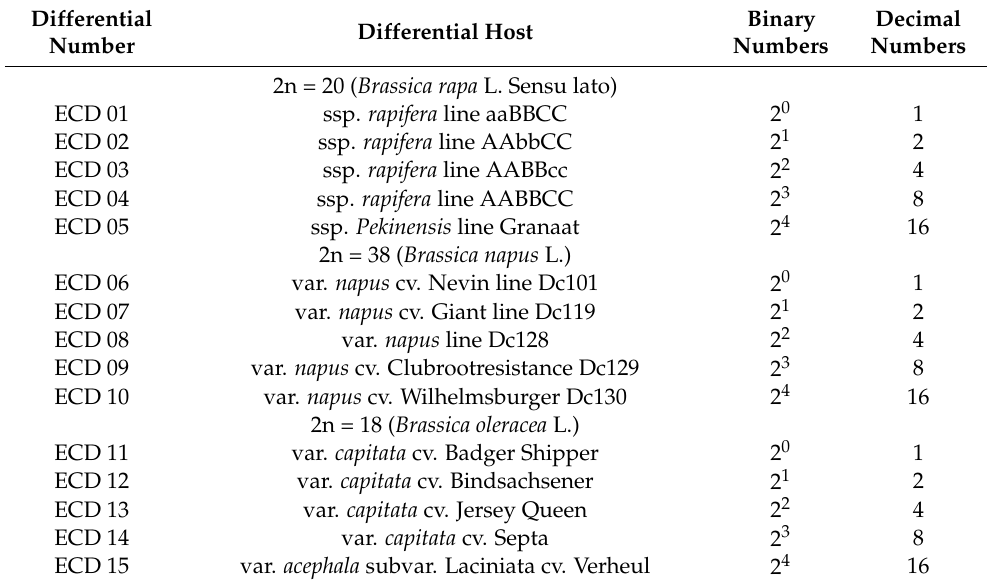
Table 2. The ECD classification system [22].